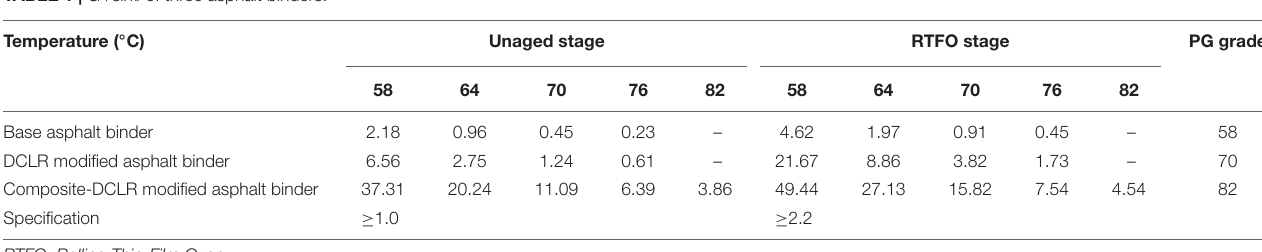
FIGURE 2 | The preparation process of the composite-DCLR added asphalt binder. TABLE 1 | G*/sin δ of three asphalt binders.